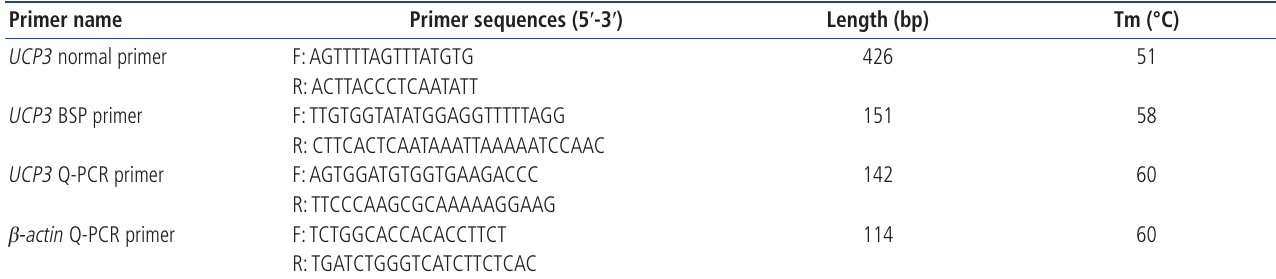
Table 1. Primer pairs used for PCR amplification Primer